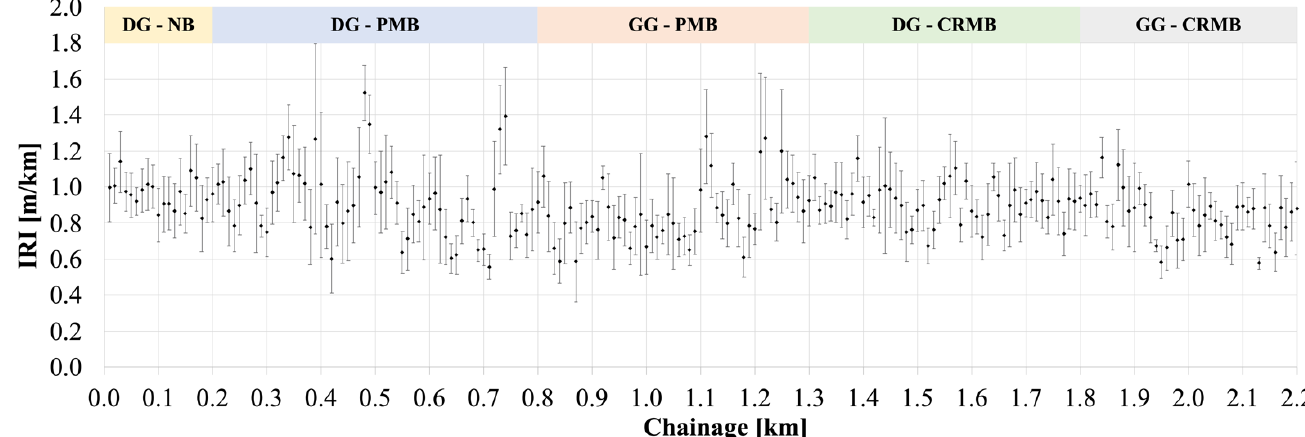
Figure 9. IRI Values for the Various Field Test Sections.